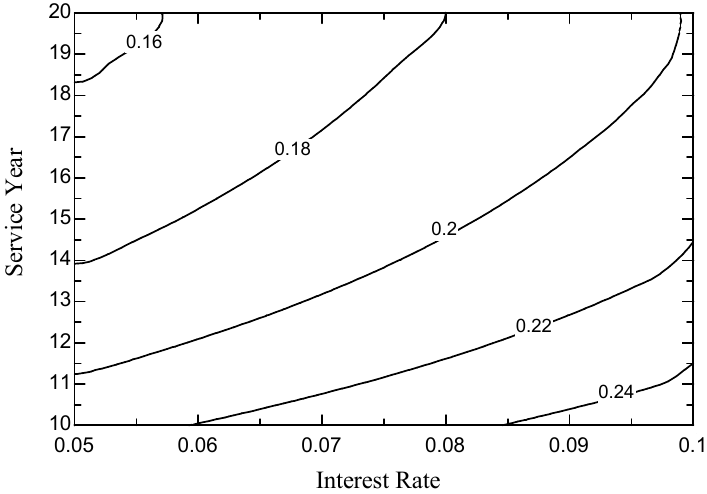
Figure 9. Variations of unit exergy cost of electricity with interest rate and service life.